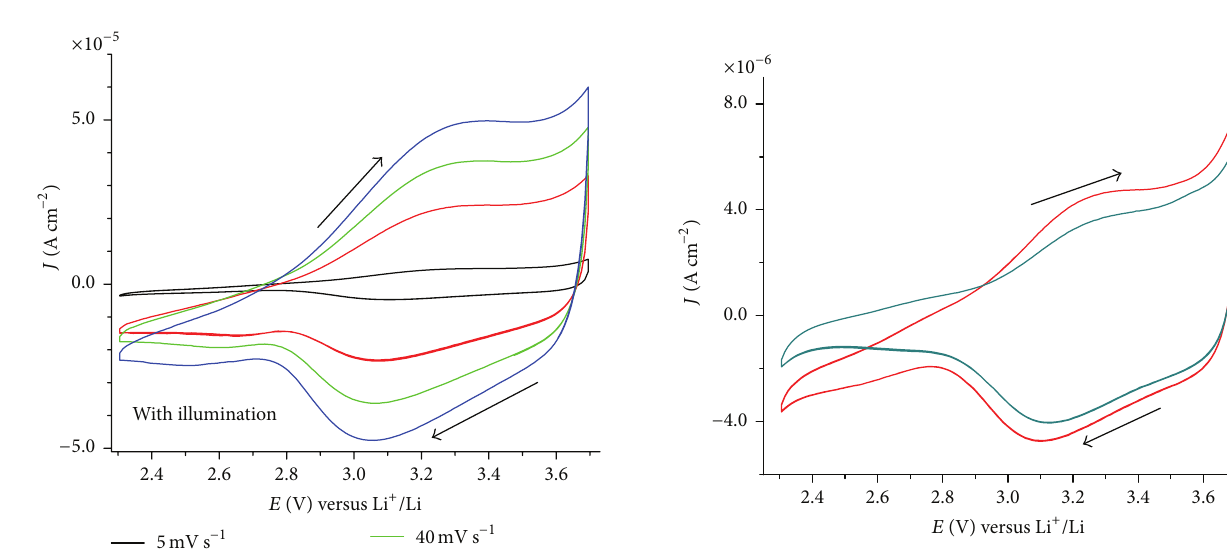
Figure 21: Cyclic voltammograms of ERY-sensitized RDS NiO spray-deposited onto ITO. All voltammograms have been under irradiation with white light (light source: halogen lamp; 𝐼 28.6 Wcm −2 ).Scanrateshavebeenvariedbetween25and55 mVs −1 . ERY-sensitized RDS NiO sample was initially cycled 60 times at 5 mV s −1 in dark conditions (see Figure 18(a)). Counter electrode: Li; reference redox couple: Li + /Li. Electrolyte composition as in Figure 1. Arrows indicate the verse of potential scan.